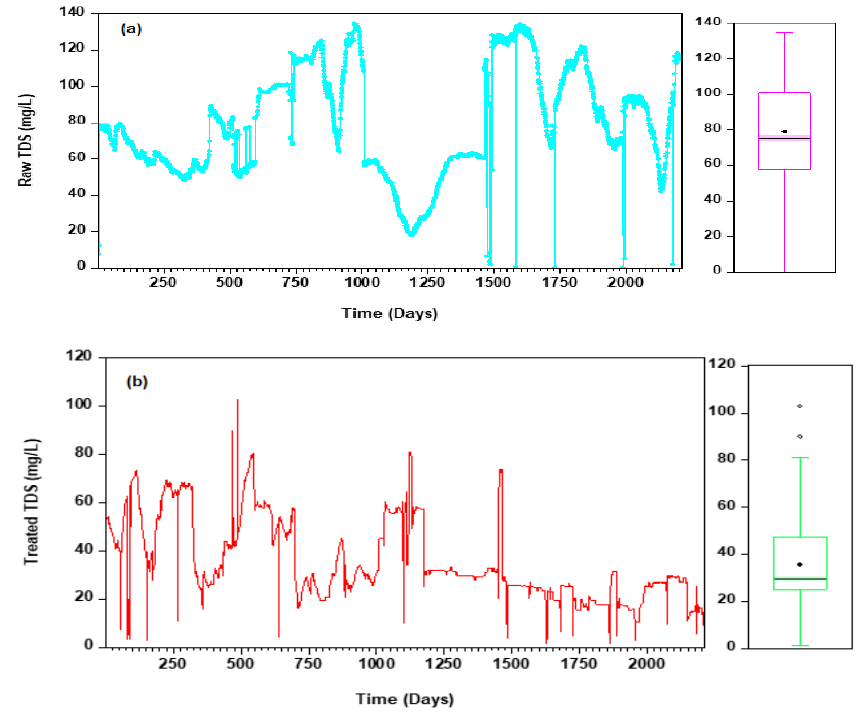
Figure 4. Plots of TDS concentration of the phytoremediation system for ( a ) influent and ( b ) effluent (treated) water samples.